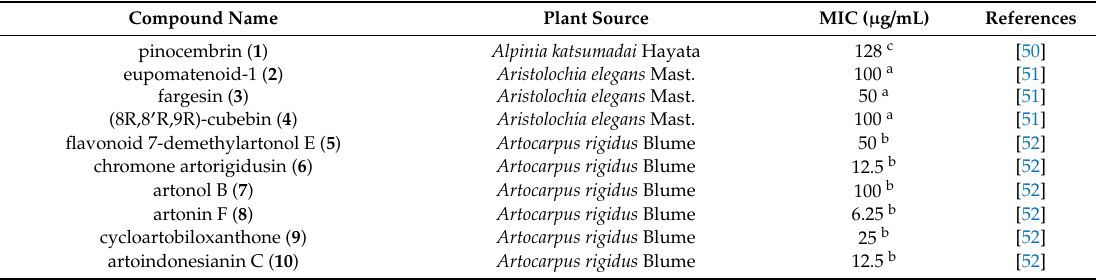
Table 1. Minimum inhibition concentrations of selected plant phenolic compounds against